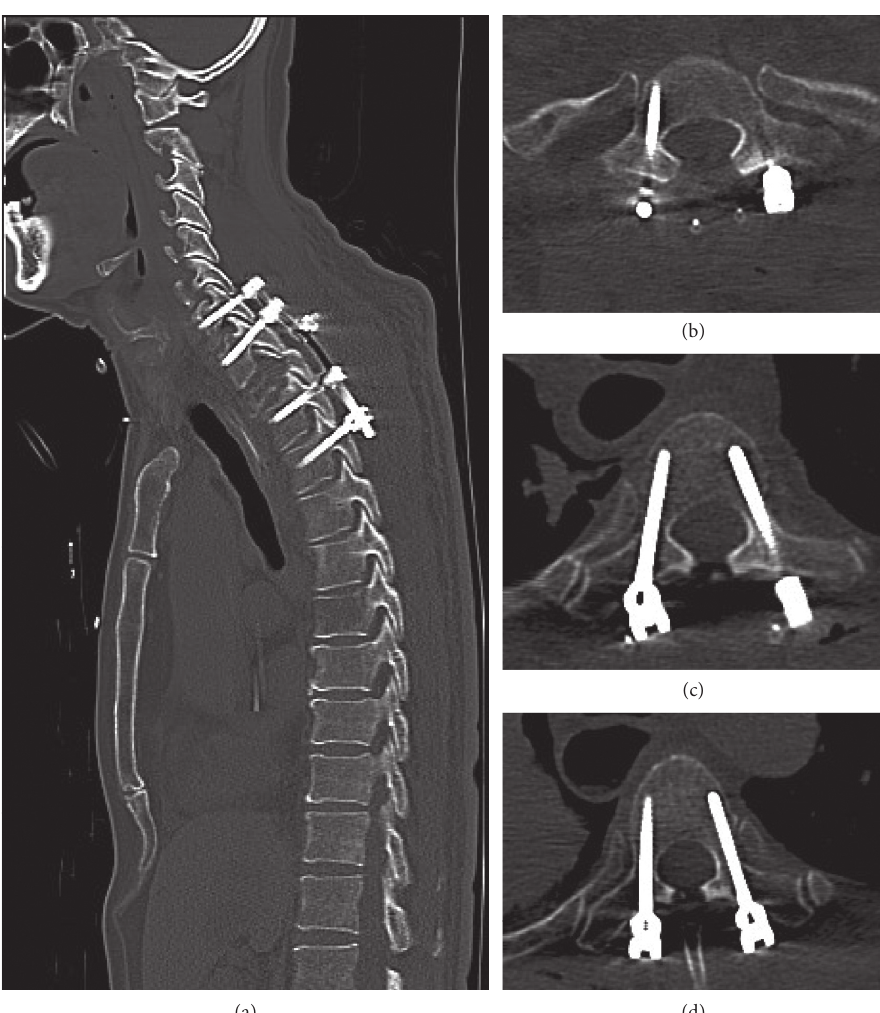
Figure 4: Postop immediate CTrevealed all screws had good position: (a) sagittal view, (b) T1 level screws, (c) T3 screws, and (d) T4